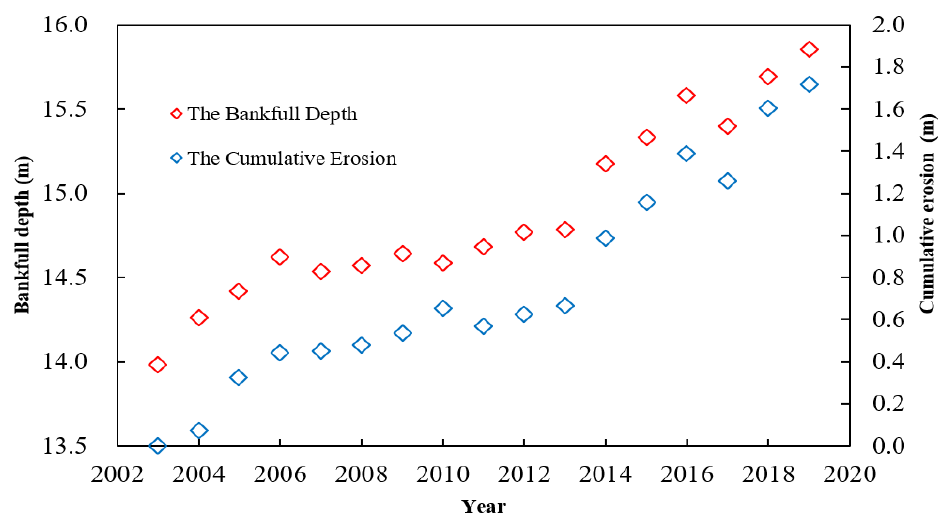
Figure 4. Variations in the bankfull depth and cumulative erosion in the Wuhan